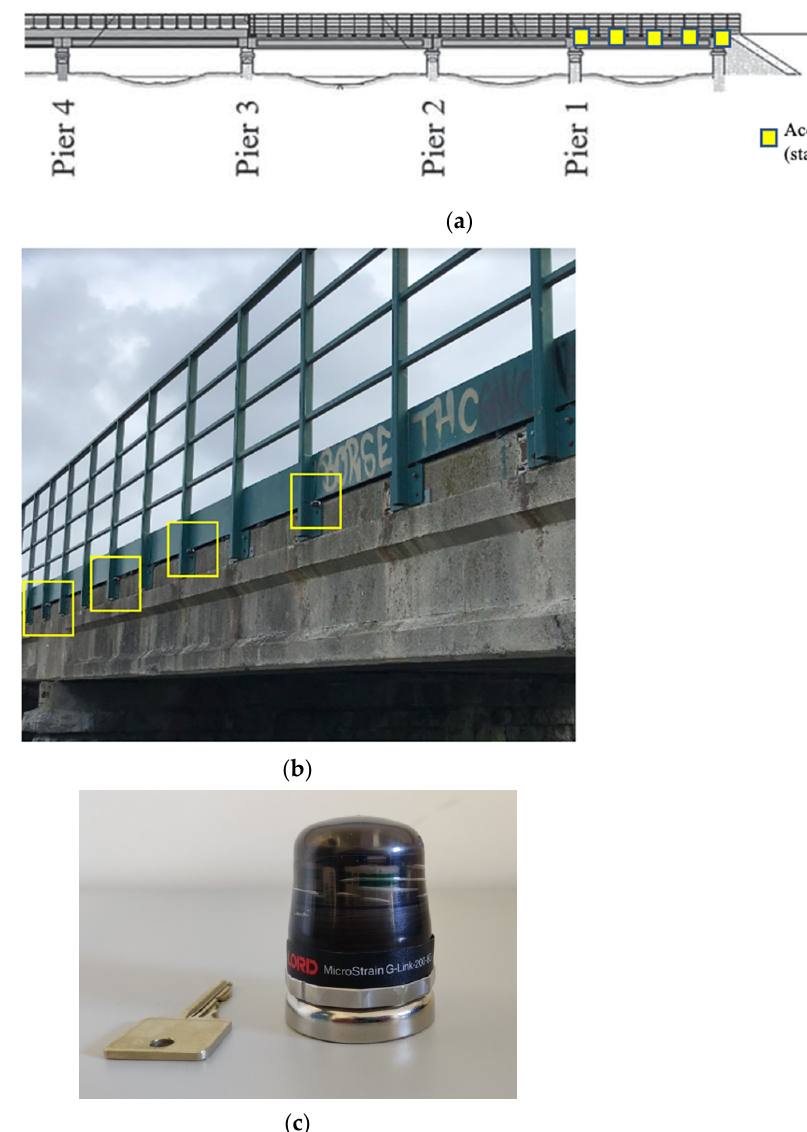
Figure 3. Layout of sensor installation for a typical stage: ( a ) plan of layout; ( b ) detail at West side (yellow boxes show the locations of installed sensors); ( c ) photo of the sensor used in direct measurements.